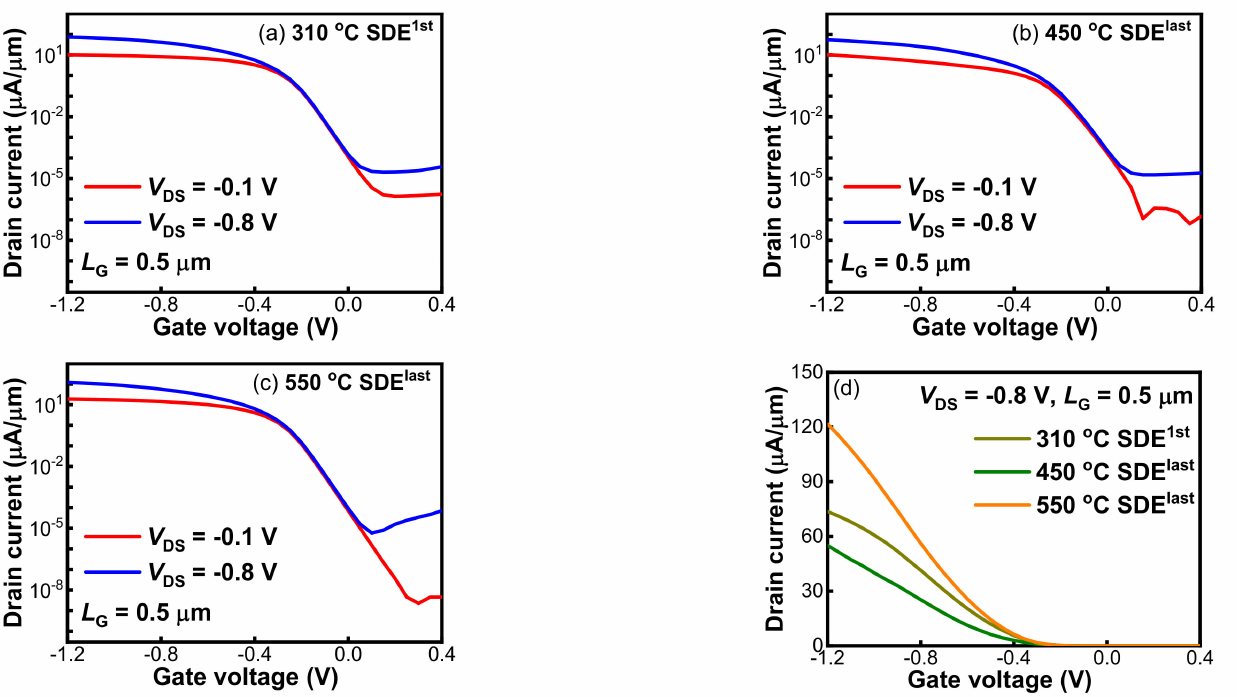
Figure 2. I DS - V GS characteristics of the Schottky S/D pFinFETs with ( a ) 310 ◦ C SDE 1st , ( b ) 450 ◦ C SDE last and ( c ) 550 ◦ C SDE last processes; ( d ) Comparison of I DS at V DS = − 0.8 V between the